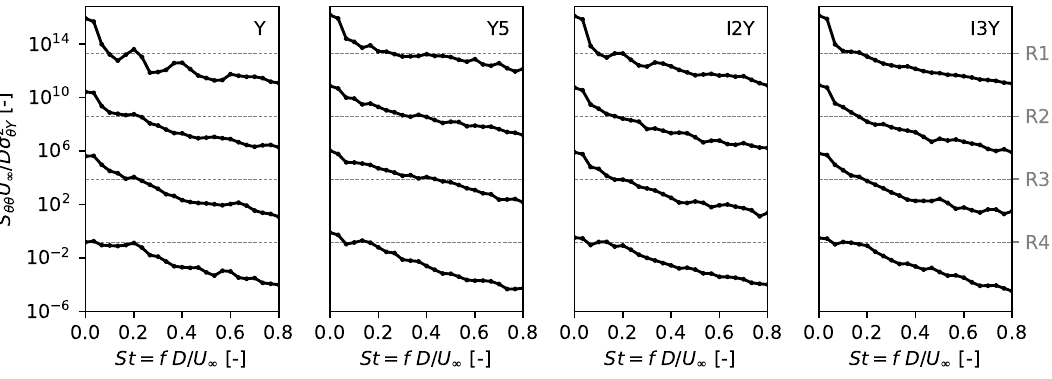
Figure 9. Row-averaged yaw angle power spectral densities S θθ as a function of Strouhal number St = f D / U ∞ . Spectra of different rows are shifted vertically for clarity. Horizontal dashed lines indicate identical reference values for each row. Spectra are non-dimensionalized using σ 2 variance of the first row yaw angles in case Y.